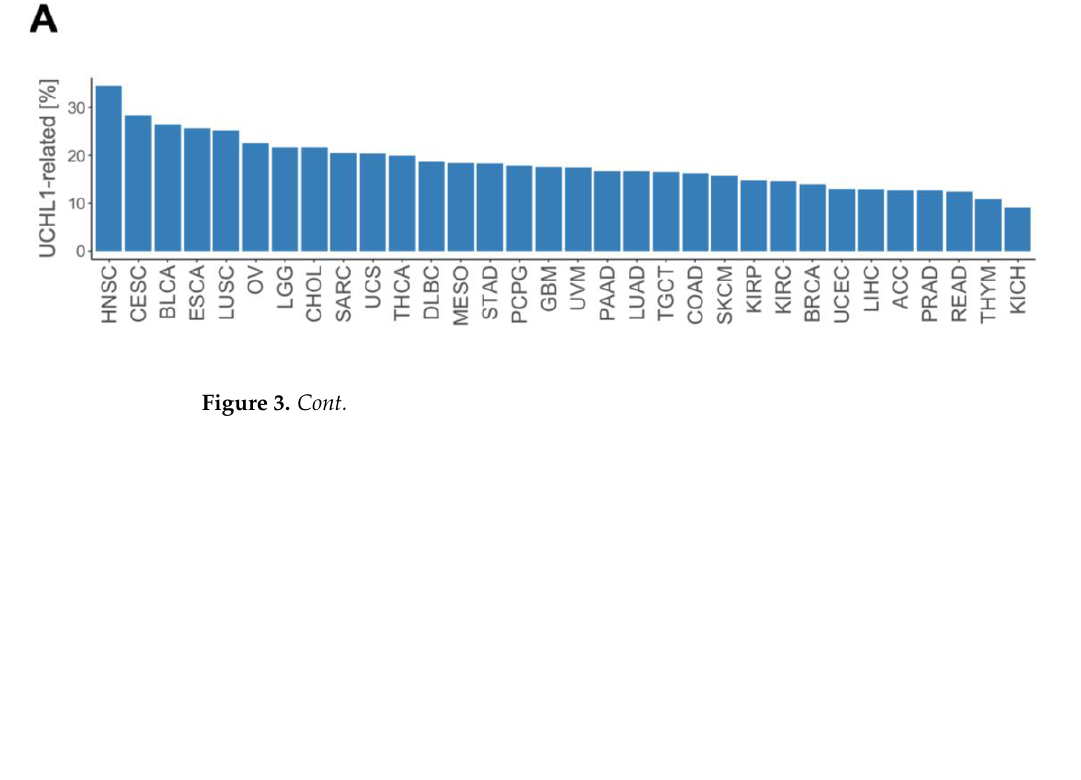
Figure 3. UCHL1-related cancers across solid tumors from TCGA-PanCancer. ( A ) Bar plot indicates relative frequency of UCHL1-related cancers across solid tumor entities of TCGA-PanCancer pre- dicted by the classification model. ( B ) Violin plots show significant differences of GSVA scores for UCHL1-related gene sets with either a negative (left) or positive association (right) to UCHL1 ex- pression between UCHL1-related (blue) and other tumors (red). ( C ) Violin plot shows a significant difference in the fraction of altered genome between UCHL1-related (blue) and other tumors (red).